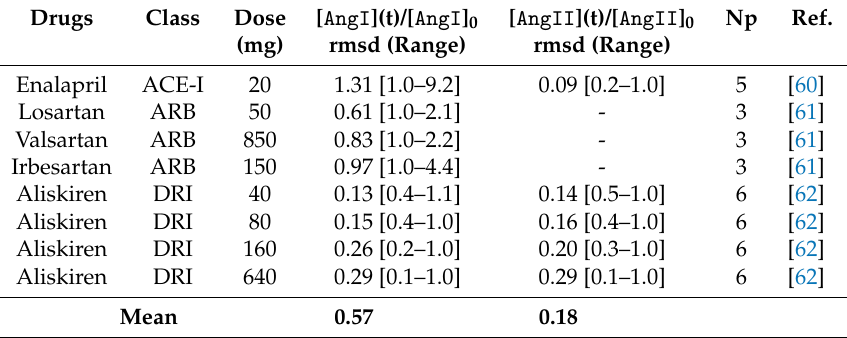
Table 3. Comparison between model predictions and experimental values of AngI and AngII levels normalized by their value before the administration of the drugs. Range is the interval of experimental values, and rmsd is the root mean square deviation between experimental and predicted values, computed over all time points; Np is the number of time points. ACE-I, angiotensin-converting enzyme inhibitor; ARB, angiotensin receptor blocker; DRI, direct renin